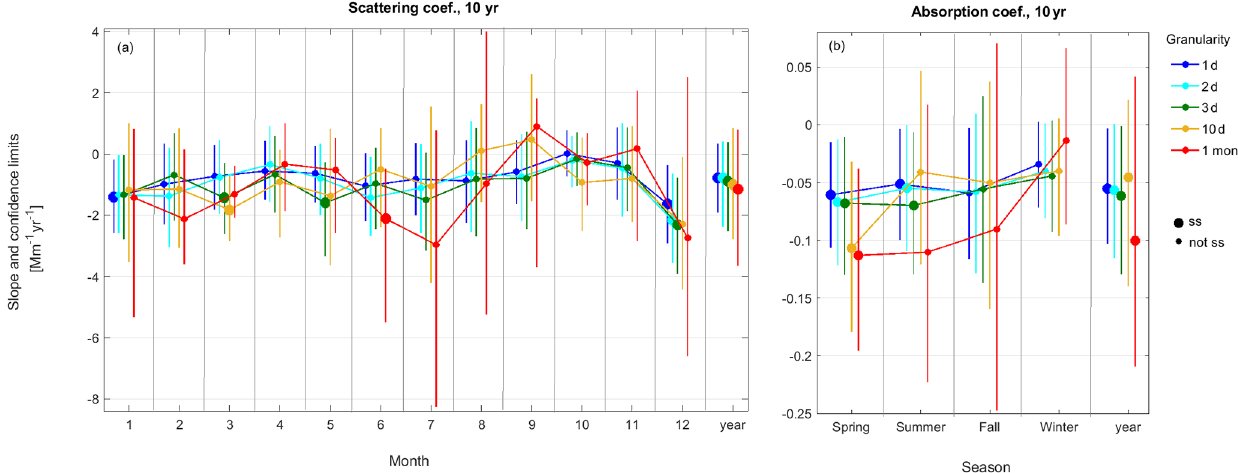
Figure 8. VCTFPW slope (dots) and CL (vertical lines) as a function of the time granularity for the division of the time series into (a) 12 months for the 10-year aerosol scattering coefficient and (b) into four meteorological seasons for the 10-year aerosol absorption coefficient. Larger symbols indicate statistically significant slopes computed from 3PW.